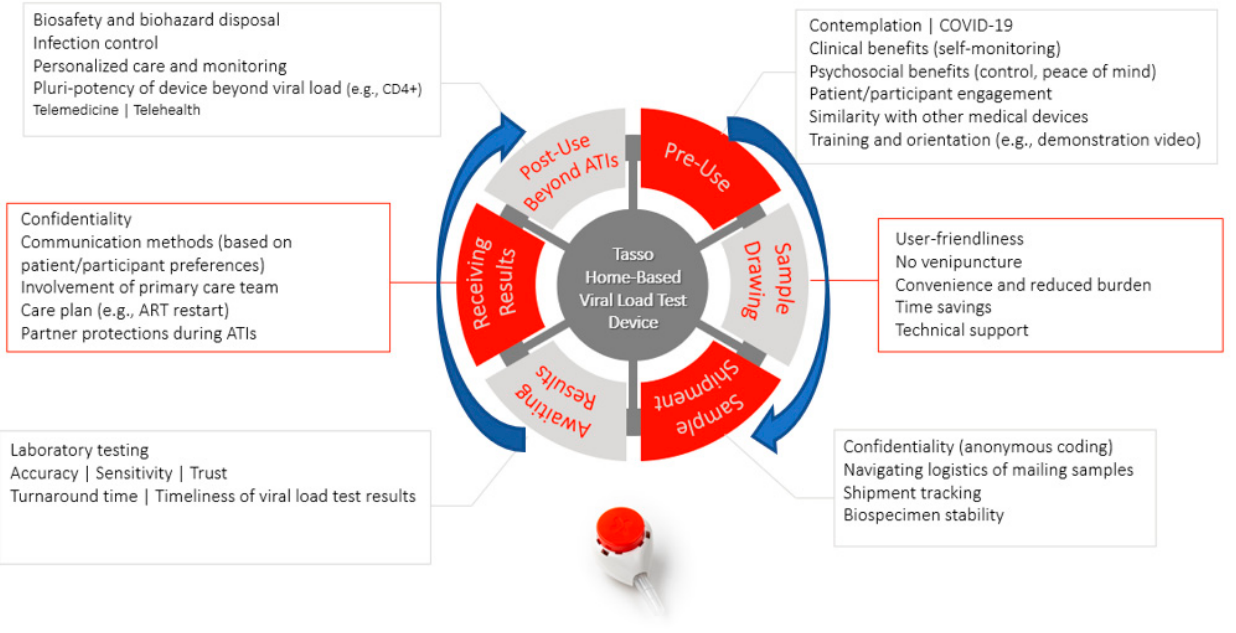
Figure 7. Patient/participant journey with home-based blood collection device for viral load testing